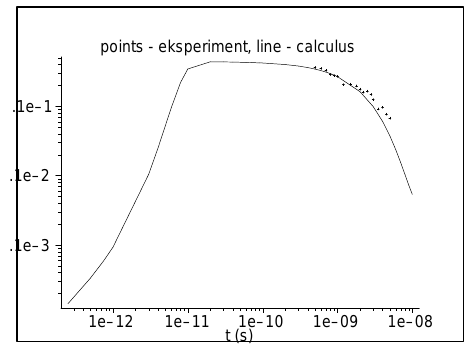
points - eksperiment, line -